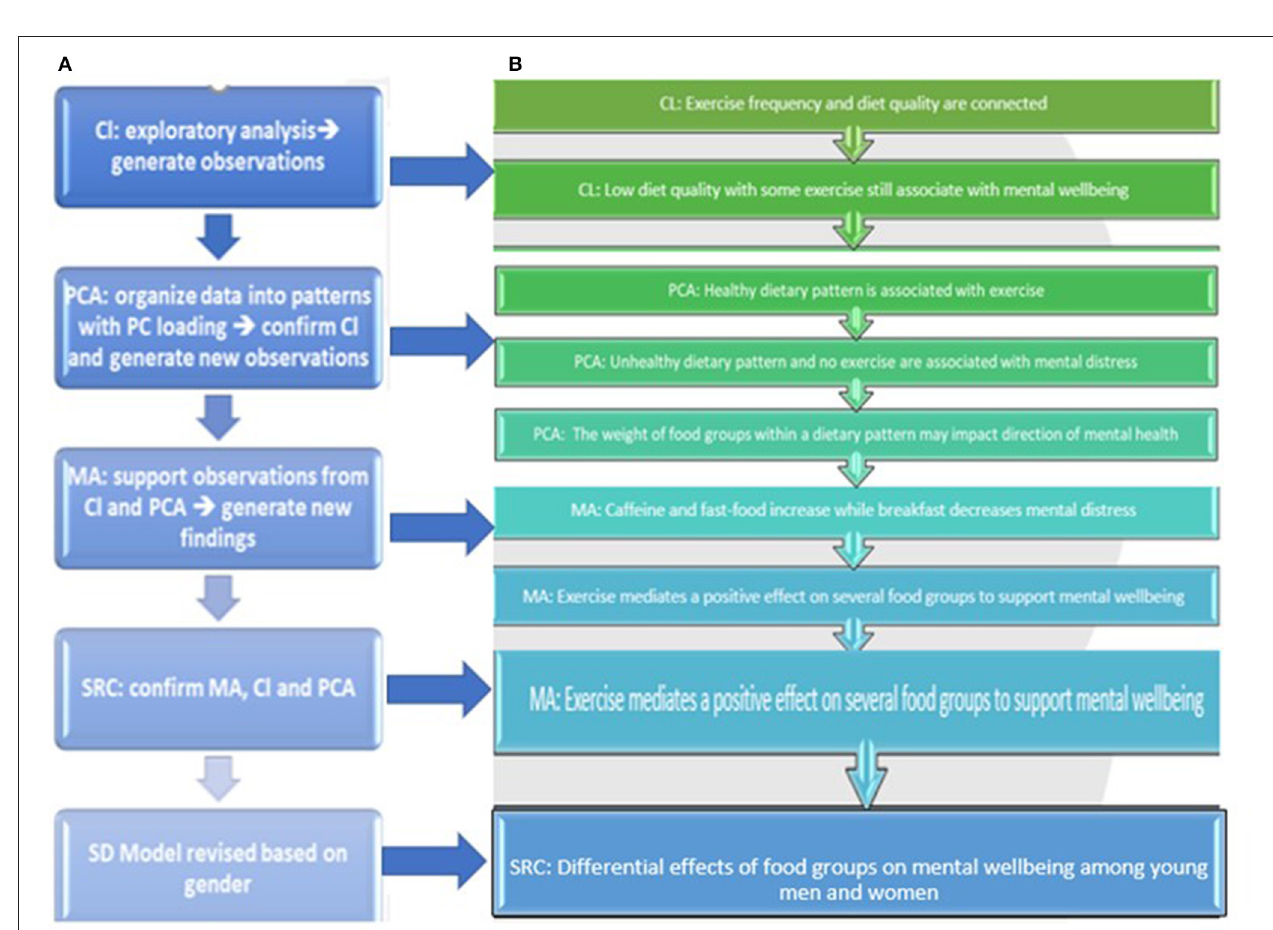
FIGURE 3 | (A,B) Research design and rationale based on sequence of the results. Cl: cluster analysis; PCA; principal component analysis; MA, mediation analysis; SRC, Spearmen’s rho correlation; SD, system dynamics.